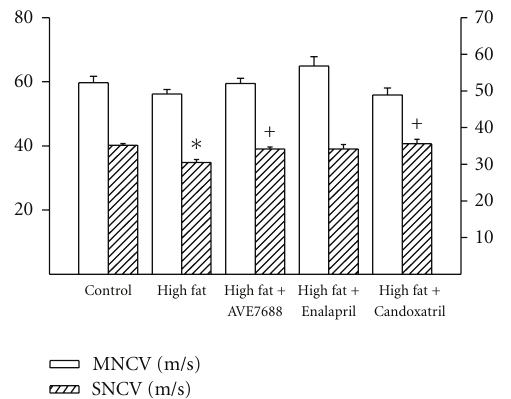
Figure 3: E ff ect of a high-fat diet and treatment with AVE7688 on thermal nociception and intraepidermal nerve fiber profiles in the hindpaw. Rats were fed a standard or high-fat diet with or without AVE7688, Enalapril or Candoxatril for 24 weeks. Data are presented as the mean ± SEM for thermal nociception in sec and intraepidermal nerve fiber profiles per mm. The number of rats in each group was the same as shown in Table 1. ∗ P < . 05, compared to rats fed the standard diet (control), + P < . 05, compared to rats fed the high -fat